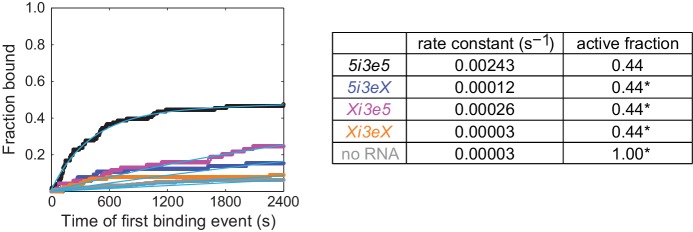
Cumulative distributions of the fraction of RNA molecules exhibiting at least one U2 binding event by the indicated time after the start of the experiment.Data include measurements on 5i3e5, 5i3eX, Xi3e5, and Xi3eX RNA molecules and no RNA control locations, all from the experiment in Figure 4C. For all four RNAs, data were consistent with a quantitative model (cyan fit lines; see [Friedman and Gelles, 2015]) that assumes a single rate-limiting step for U2 binding (with the indicated values for the apparent first-order association rate constant) to only a subpopulation (the ‘active fraction’) of the RNA molecules. The active fraction was determined from the fit to the 5i3e5 data and was held fixed at the indicated values (asterisks) for the other fits.